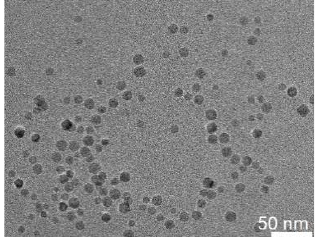
Figure A4. TEM images of iron oxide NPs coated with ATRP initiator molecules.